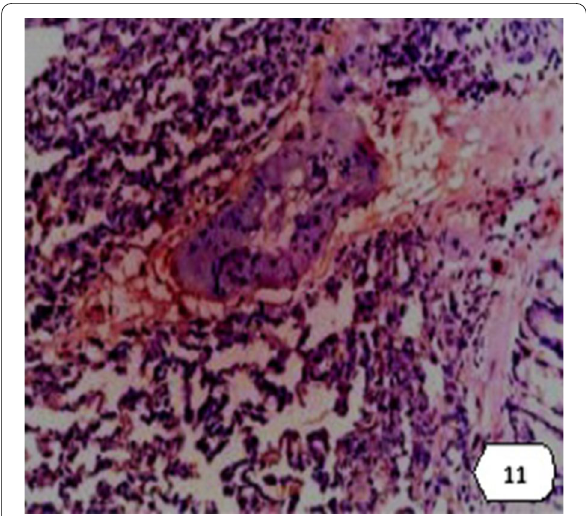
Fig. 11 Lung tissue image of INDOX-administered animals showing mild positive COX-2 immunoreactivity around lung capillaries, bronchioles, and interstitial tissues ( 400 magnification) ×